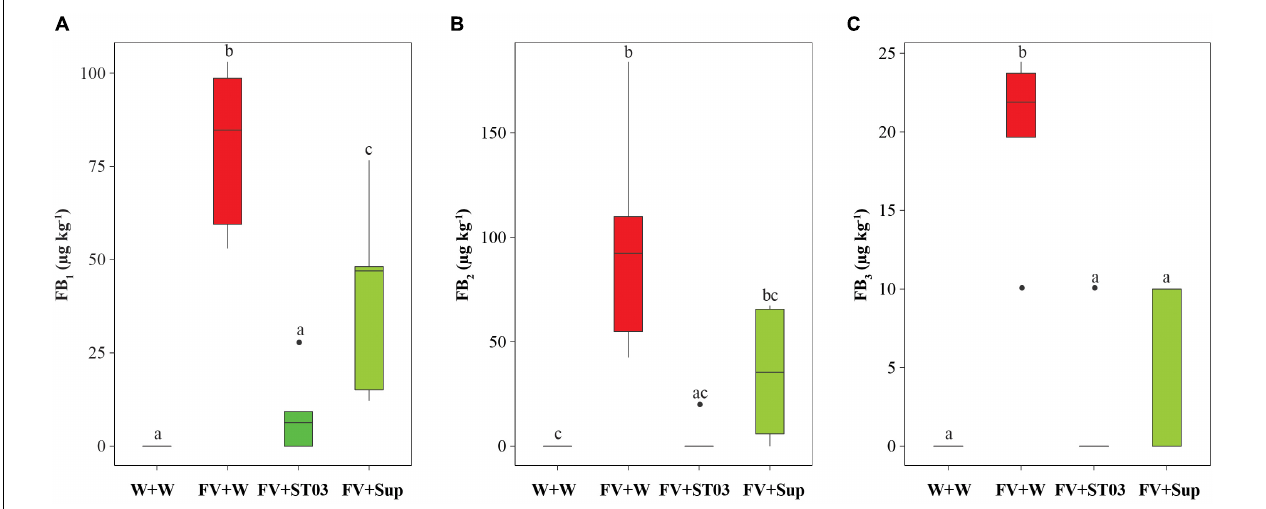
FIGURE 5 | Impact of the Streptomyces strain ST03 on the production of fumonisin B 1 (FB 1 ) (A) , FB 2 (B) , and FB 3 (C) by Fusarium verticillioides on maize cobs. The negative maize cob control was inoculated with sterile water (W + W), positive maize cob control comprised F. verticillioides and sterile water (FV + W), the two biocontrol treatments included F. verticillioides and the Streptomyces cell suspension (FV + ST03) or the supernatant of the strain ST03 (FV + Sup). Different letters above each box depict the significant difference using a Kruskal–Wallis test followed by a post hoc Dunn’s test at a significant level of α = 0.05. Five biological replicates were performed per treatment. The experiment was repeated